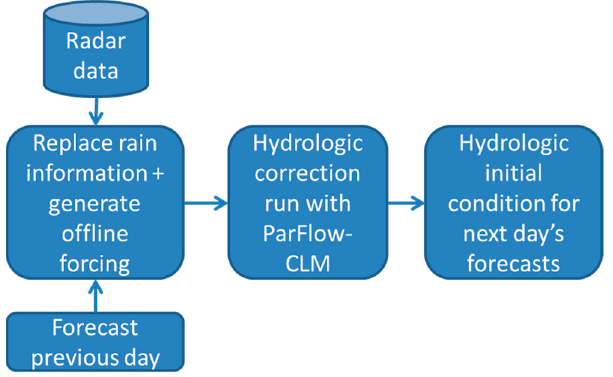
Figure 4. Schematic of the different dependencies between the tasks in the workflow of the correction run.